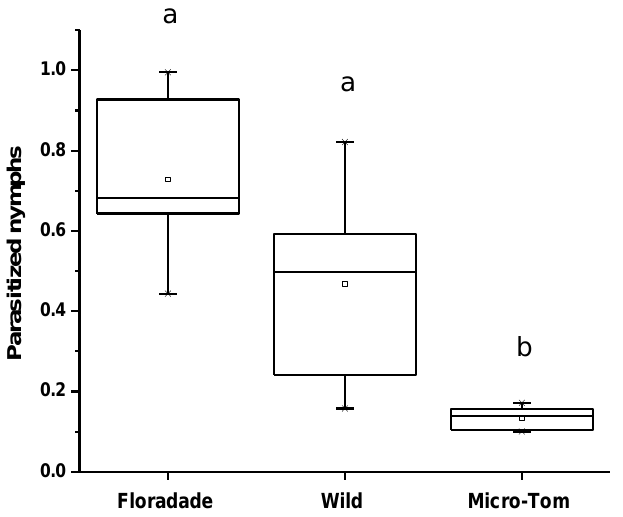
Figure 2. Average nymphs of B. cockerelli parasitized by T. triozae in different tomato varieties (Floradade, Wild, and Micro-Tom). Different letters indicate statistical differences ( p < 0.05).